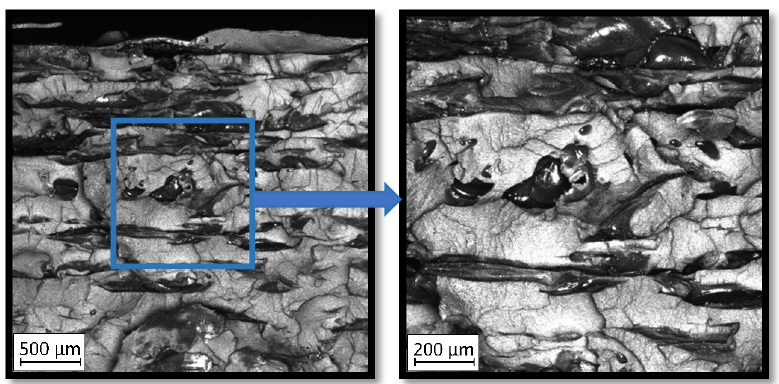
Figure 14. Fracture images of overlap joint of PLA-ABS